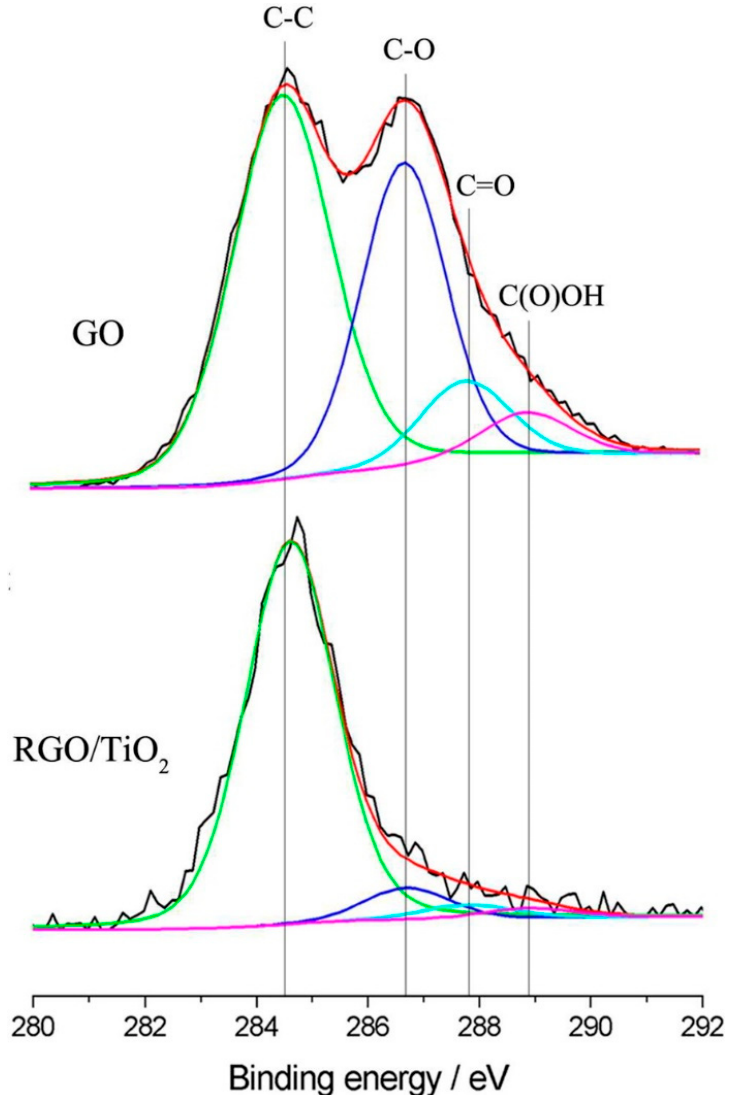
Figure 22. XPS spectra of C 1s for GO and TiO 2 /RGO nanocomposites. From peak area, the reduction of GO was calculated as 76.5%. Reprinted with permission from reference [122]. Copyright 2013 American Chemical Society.